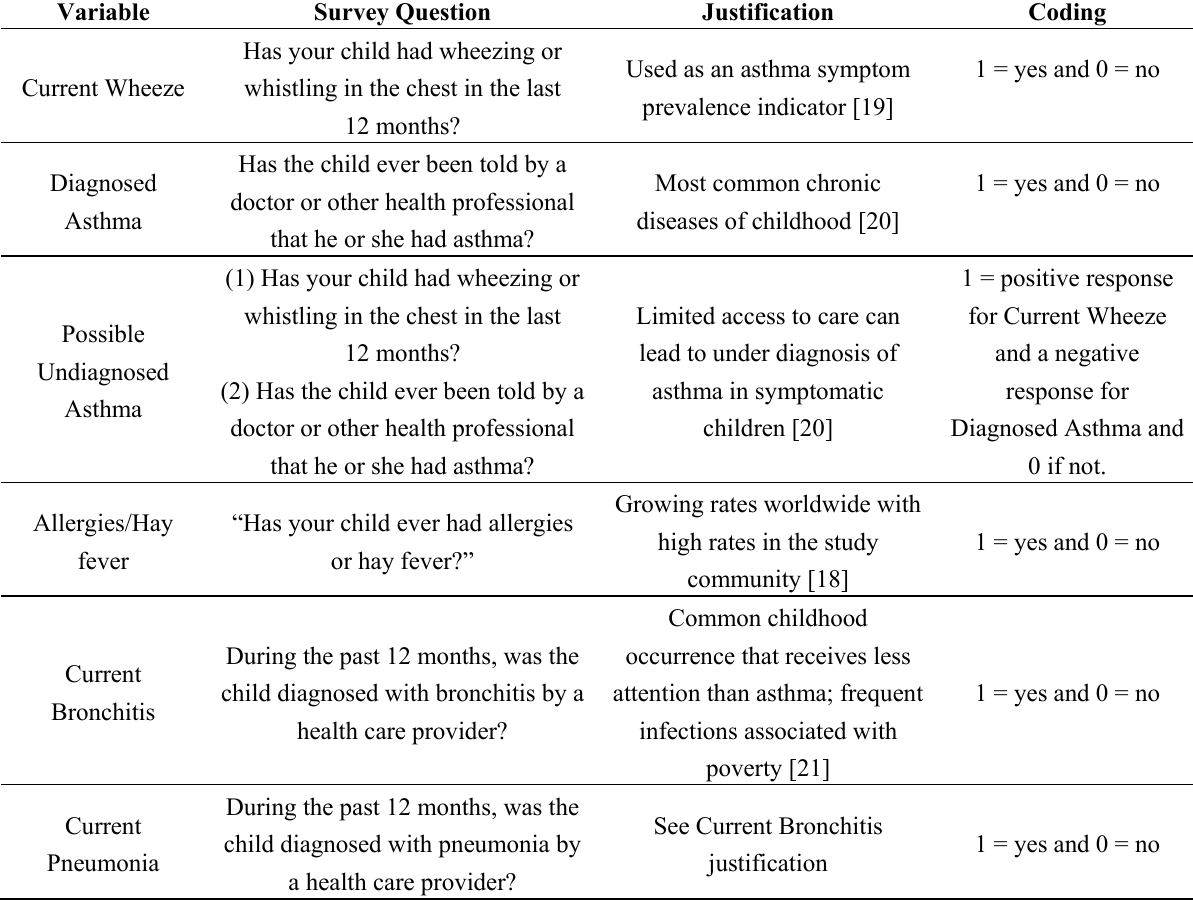
Table 1. Respiratory health problems: survey questions, justification and coding. Variable